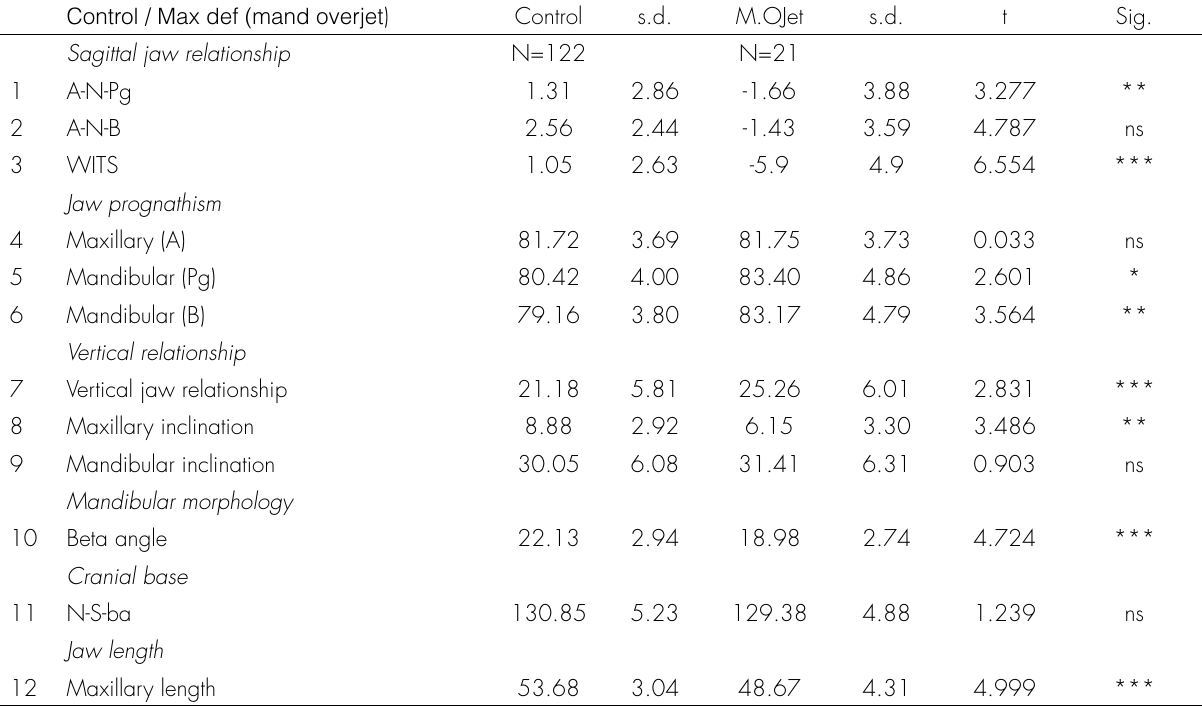
Table IIId. Comparison between groups of the experimental material and the control material in terms of exhibiting a reverse overjet of all four